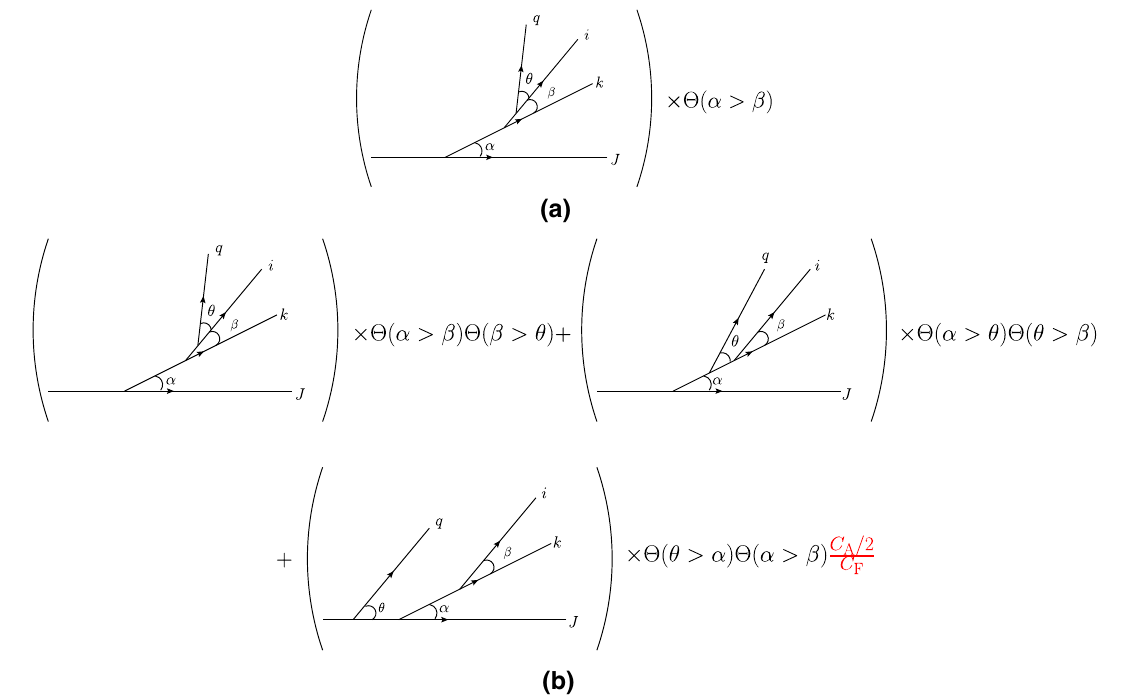
Fig. 5 Diagram a is generated by our dipole shower and is chosen because it contains an incorrect colour factor. Diagram b represents the re- arrangements of a corresponding to an angular-ordered shower. The red colour factor is the N − 2 c suppressed error produced by our original